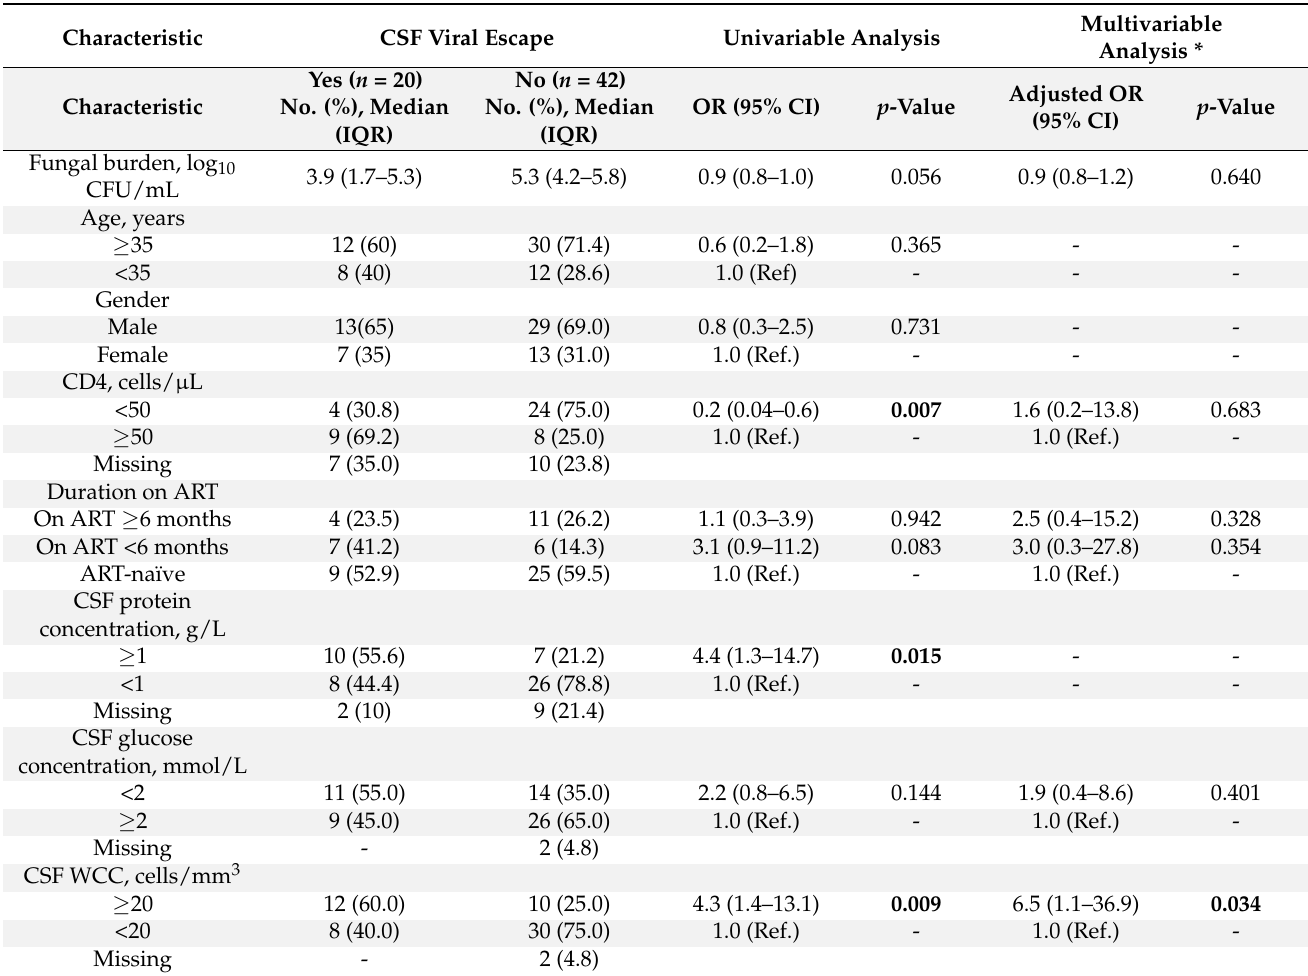
Table 2. The odds of having CSF viral escape were 4.4-fold (95% CI, 1.3–14.7, p = 0.015) higher in individuals with protein concentration ≥ 1 g/L; however, we could not include both protein concentration and CSF WCC a priori because of multicollinearity between these variables. The odds of having CSF viral escape were 80% lower in individuals with CD4+ T-cell count < 50 cells/ µ L; however, the response was the opposite, and the association was lost in a multivariable analysis ( p = 0.683) possibly due to multicollinearity. ART status, duration on ART, CSF viral escape, and CD4+ T-cell count were not associated with mortality or mental status (data not shown). Table 2. Factors associated with CSF HIV-1 viral escape prior to antifungal therapy. Multivariable CSF Viral Escape Univariable Analysis Analysis